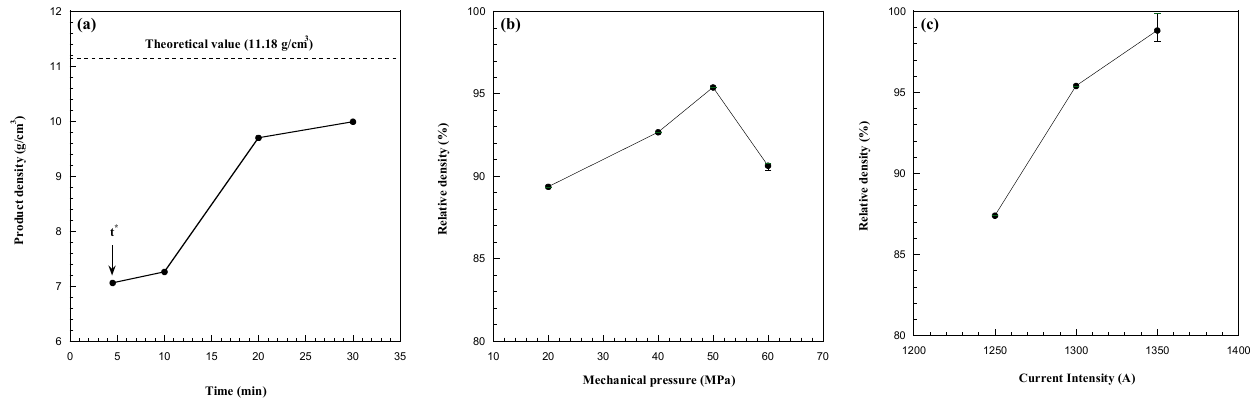
Figure 3. Effect of ( a ) the sintering time ( I = 1300 A, P = 20 MPa); ( b ) the mechanical = 30 min) and ( c ) the applied current ( P = 50 MPa, t pressure ( I = 1300 A, t T the density of HfB samples obtained by R-SPS. Adapted from 2